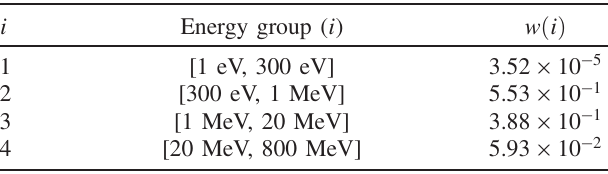
TABLE II. Spallation spectrum energy groups and their corresponding weighting factors.